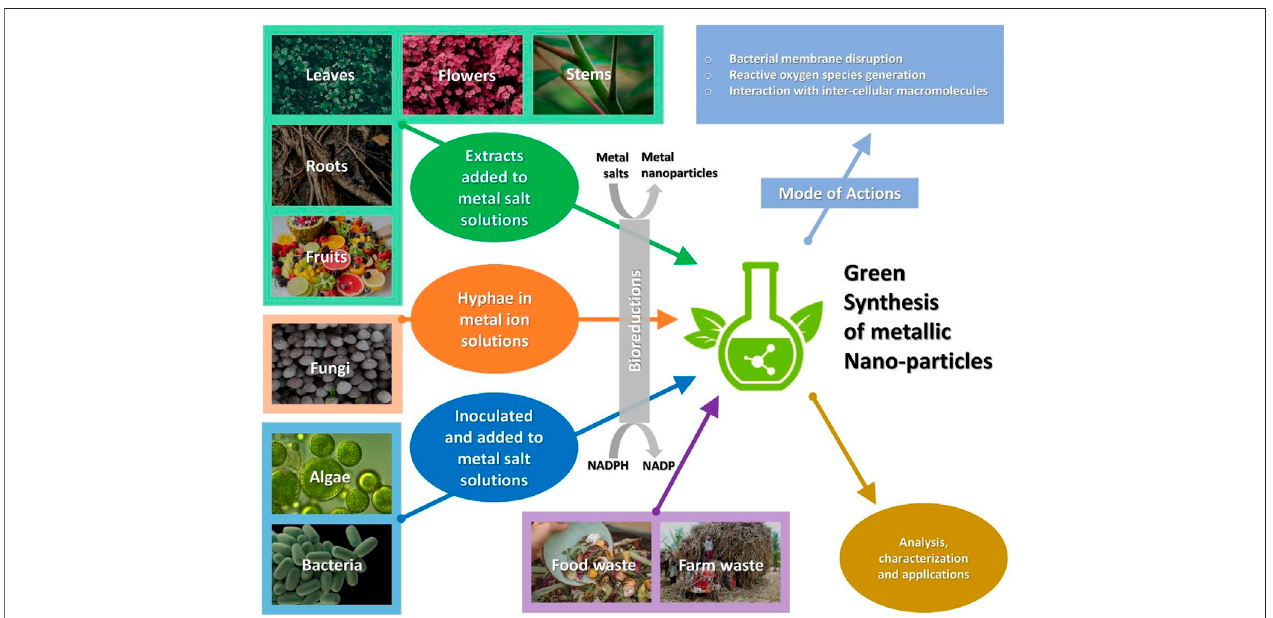
FIGURE 2 | Green synthesis of metallic nanoparticles from various sources, mode of actions and further processes.